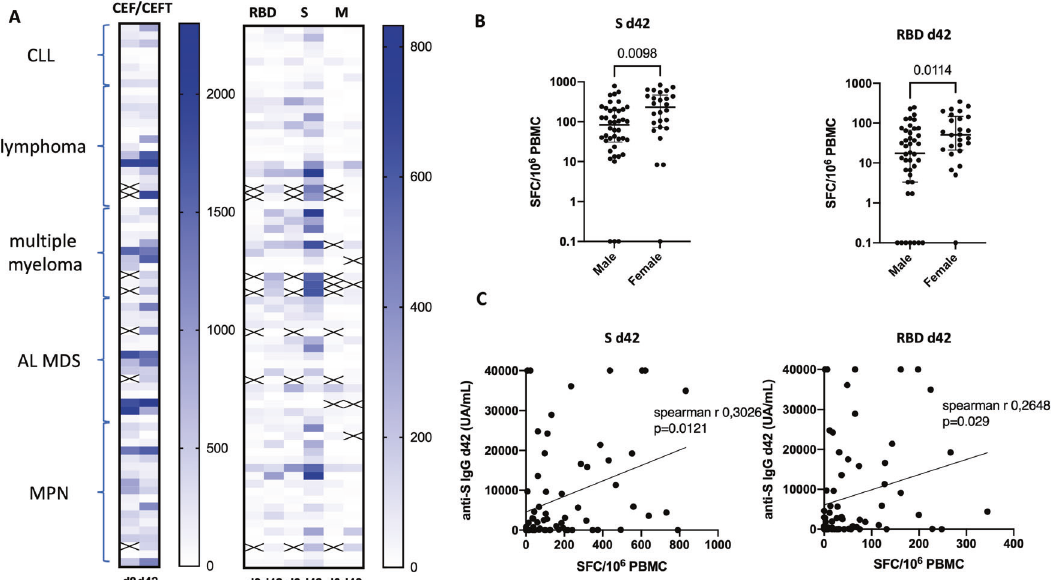
Fig. 4 T-cell response to COVID-19 BNT162b2 vaccine. A T-cell response was assessed by IFN- γ ELISPOT at baseline (before fi rst BNT162b2 vaccination, d0) and 2 weeks after the second BNT162b2 vaccination (d42), n = 68. T-cell response against CMV, EBV, In fl uenza virus, and Tetanus toxoid (CEF/CEFT, left panel). T-cell response against SARS-CoV-2 spike protein (S), or its receptor binding domain (RBD), or against membrane protein (M) (right panel). Cross indicates missing data. CLL chronic lymphocytic leukemia, AL MDS acute leukemia and